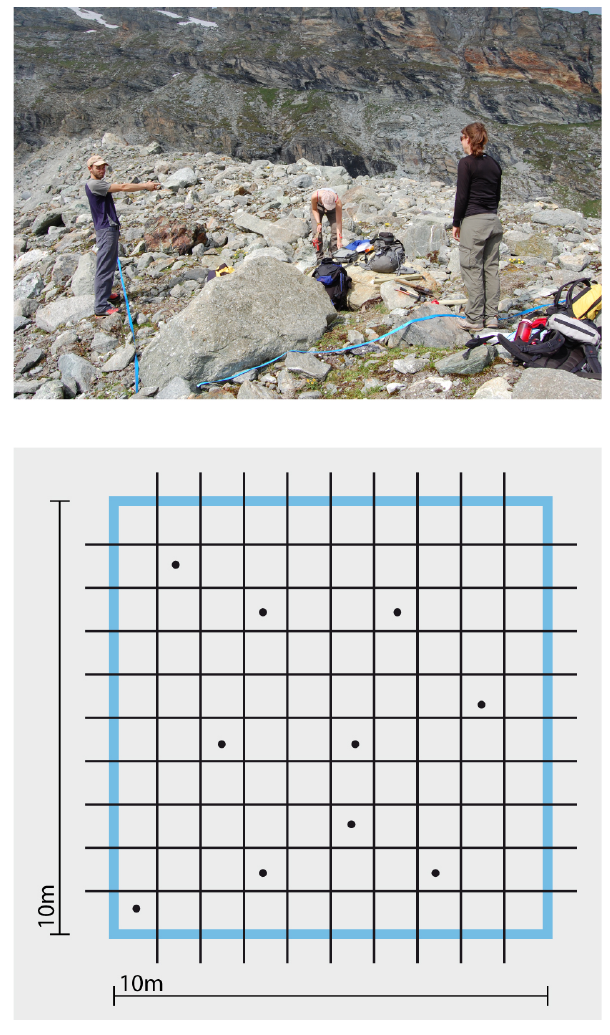
Fig. 3. Ten iButtons were randomly distributed in each 10m × 10m footprint. One vertex of the square was marked with a stick. Two ropes representing two orthogonal edges were attached to the stick. The blue ropes served as rulers. The local grid and the sampled numbers were manually recorded.